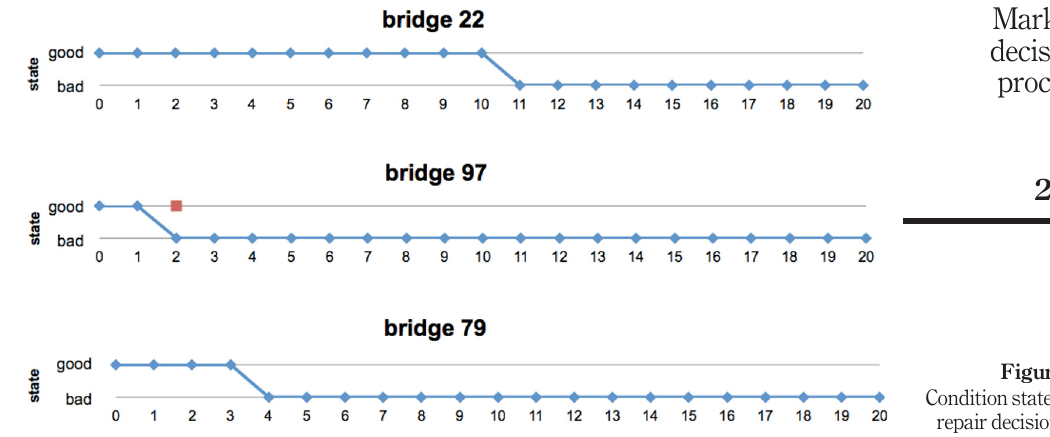
Figure 3. Condition state and